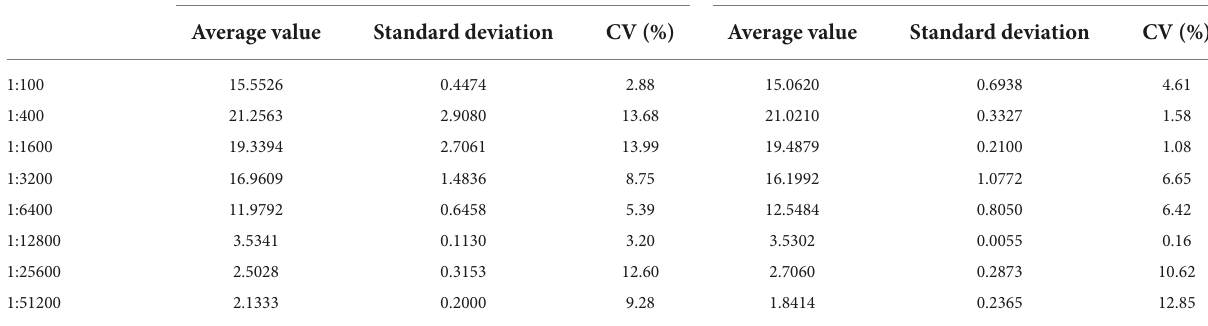
TABLE 1 Stability of the p35-Luc LISA. Dilution ratio